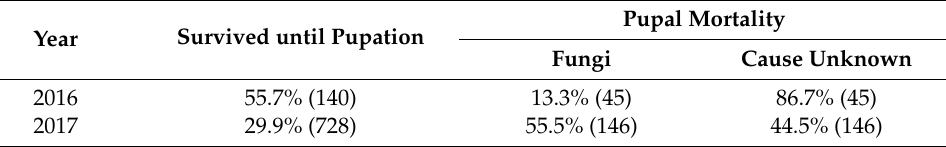
Table 3. Demographic parameters of C. pusaria in the field experiment. Total sample size is shown in